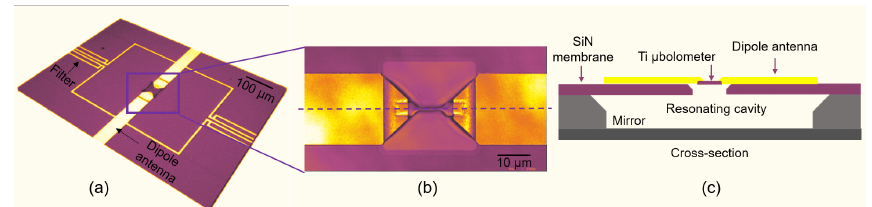
Figure 1. The photo of the designed terahertz titanium-based microbolometer with antenna and filters ( a ). The enlarged view of the bridge active part of the microbolometer: the antenna area is approximately 500 µ m × 500 µ m, the geometry of visible titanium bridge amounts to 12 µ m length and 2 µ m width ( b ). The cross-section of microbolometric detector. Note that the selectivity was enhanced by adjustment of the dipole antenna geometry and the resonant-cavity design: back side reflection mirror was positioned at the quarter wavelength distance ( c ). Adapted from Refs. [23,24].